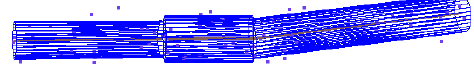
Figure 4: Cylinder-based representation of sample